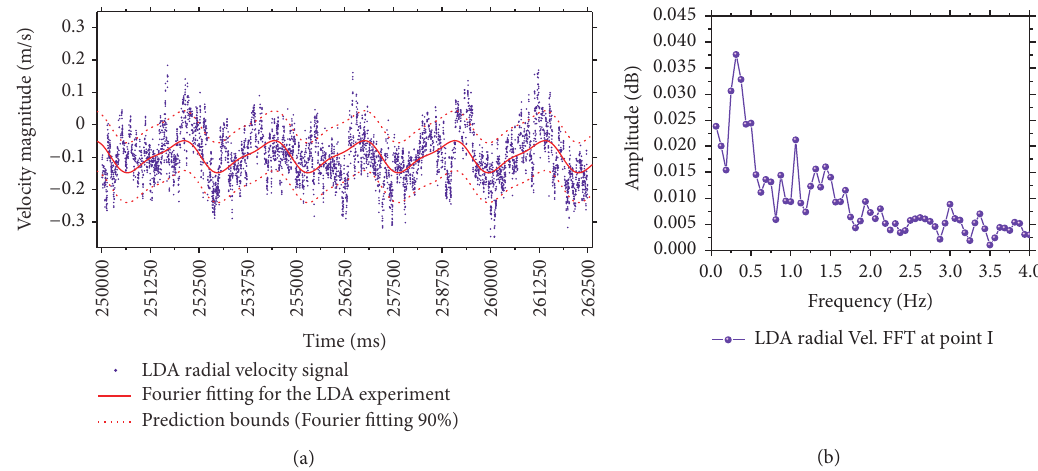
Figure 5: (a) LDA data of radial instantaneous velocity in time series; (b) FFT spectrum of signal in (a) at point ( r/ 𝐷 𝑟 = 0.32, z/ 𝐷 𝑟 = 0.38, and 𝜃 = 0 ∘ ), 𝑁 = 250 rpm.